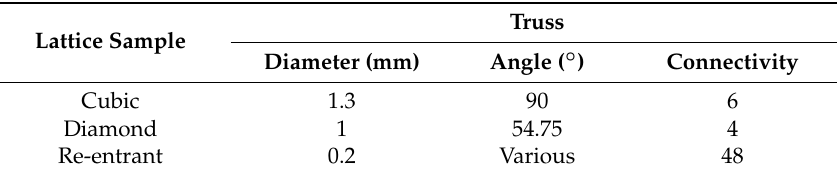
Figure 1. Schematic view of the unit cells of the three lattices studied (as specified in the original CAD design used for manufacture): ( a ) Cubic; ( b ) diamond-like and ( c ) re-entrant cube. An intersecting plane (in the x – y plane) is shown to highlight the changing angle of the trusses to the powder bed. (CAD: Computer aided design.) Table 1. Beam element features of designed lattice structures.